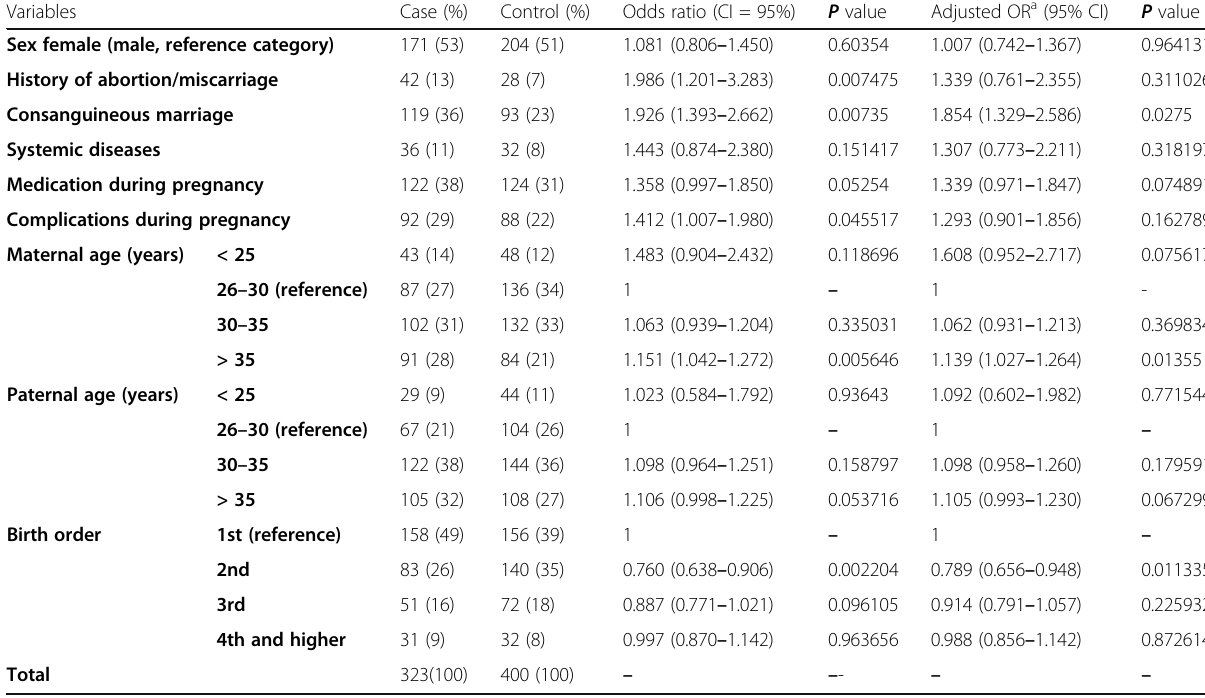
Table 1 The association between the risk factors and development of OF